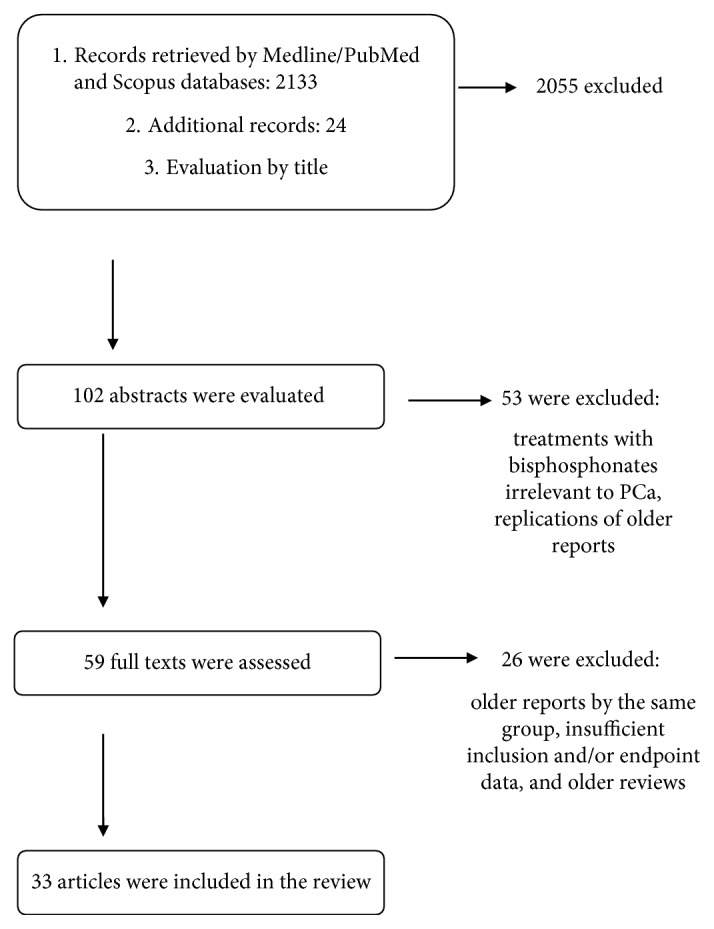
Flowchart of the review process.